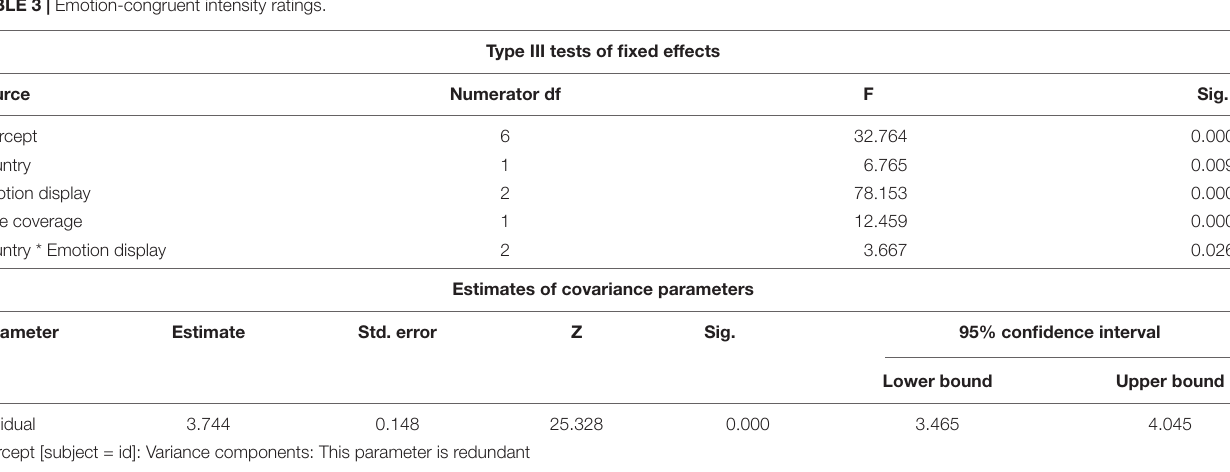
TABLE 3 | Emotion-congruent intensity